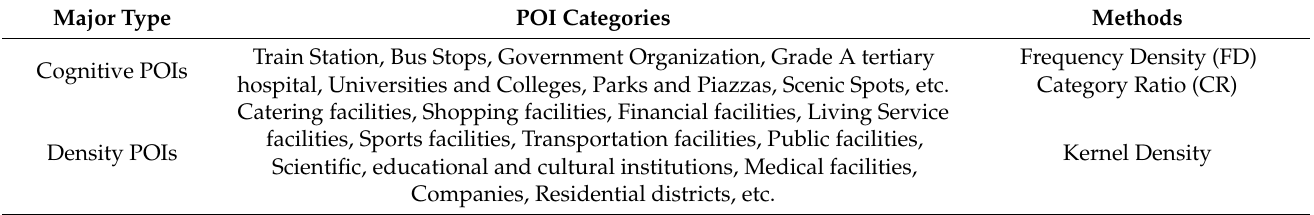
Table 1. The identification methods for two major types of